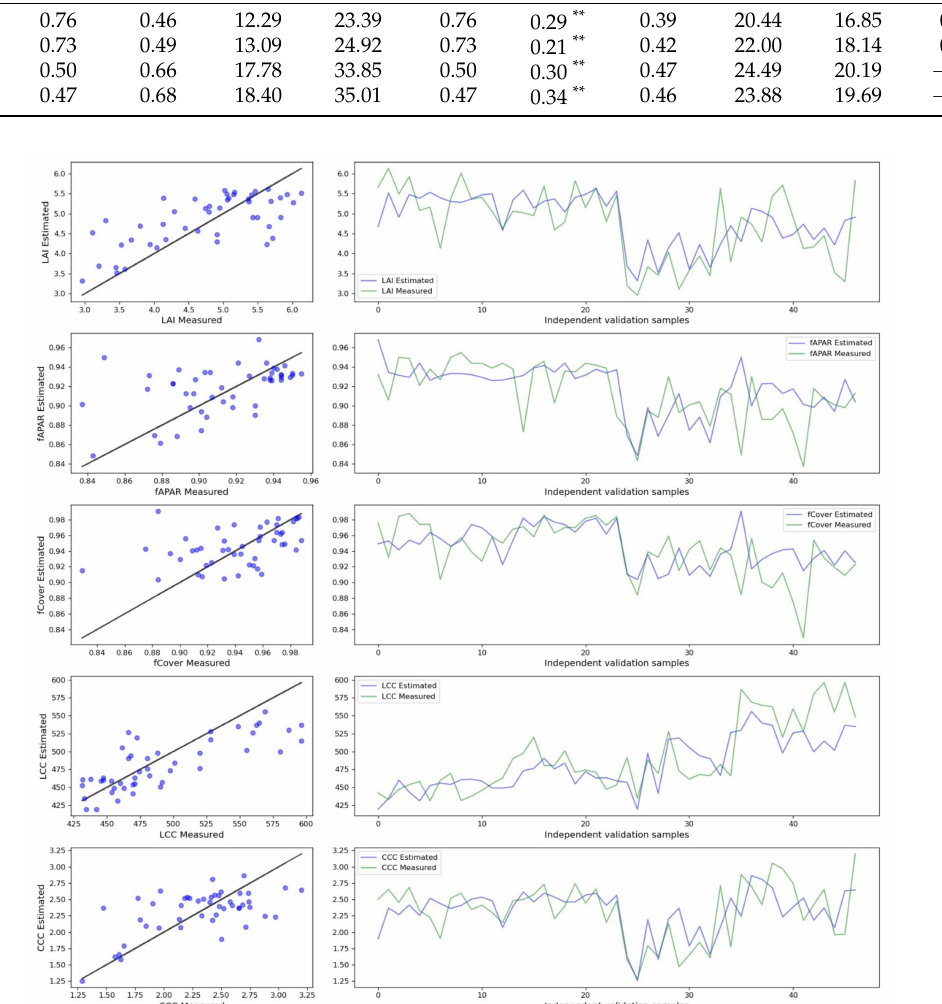
Figure 5. Relationship between observed and predicted biophysical variables. The predicted biophys- ical variables are from the best performing nonparametric model (GPR). The black line is 1:1 line. According to the cross-validation results, good models with parametric methods were found only for fAPAR and fCover with the goodness-of-fit metrics for the optimised models and test dataset, R 2 from 0.35 to 0.49 and nRMSE from 0.65 to 0.69 (Table 9 and Figure 6). Both variables were best retrieved with 3BSI-Wang VI and polynomial